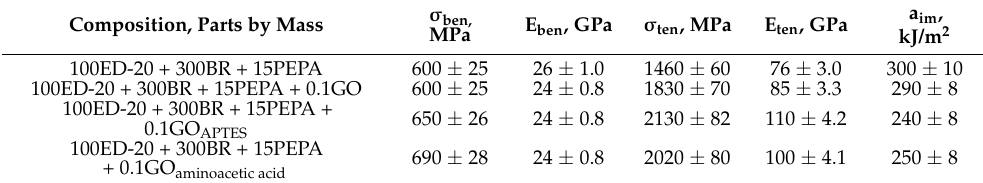
Table 5. Properties of reinforced epoxy composites.